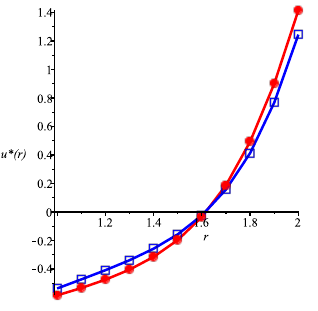
Figure 6. Optimal control in the interval [ 1,2 ] when b = q = θ = 1, k 1 = 1, k 2 = 2, and λ = 1 (with the squares) and λ = 0 (with the